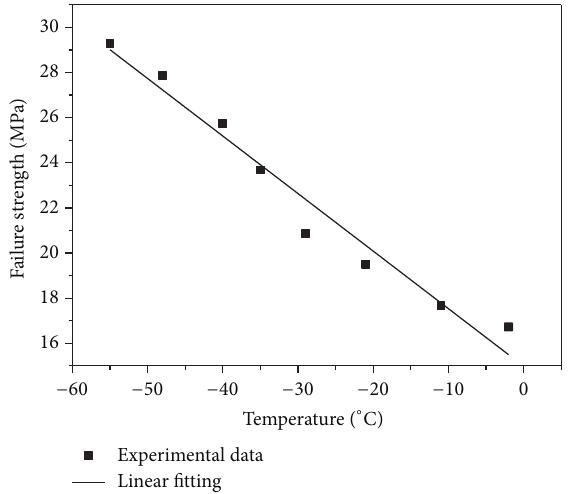
Figure 3: Failure strength versus temperature of the